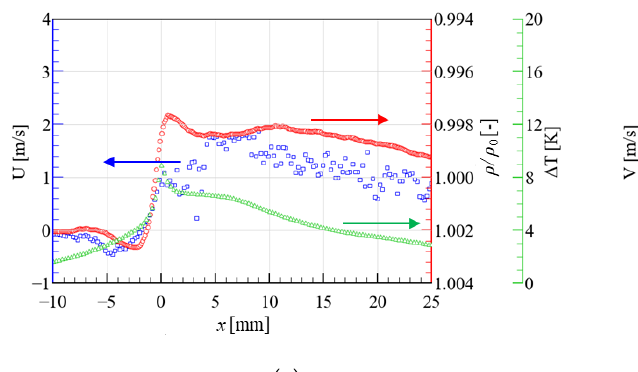
Figure 17. x -profiles of the flow, density field of the wire-PA: ( a ) x -profiles of the horizontal velocity ( y = 0.8 and 2.171 mm) and density ( y = 0.772 and 2.161 mm); ( b ) x -profiles of the vertical velocity ( y = 0.8 and 2.171 mm) and density ( y = 0.772 and 2.161 mm). Using the above results, we discuss the forming mechanism of the flow field, density field, and temperature distribution of the wire-PA, according to Figure 18. It is considered that the EHD force radiated from the wire electrode, owing to the diffusive plasma gen- eration around the wire electrode. In other words, not only a forward but also an upward EHD force was generated near the wire electrode. In addition, a Joule heating field was generated around the electrode. As a result, backward flow and a flow jump were induced near the exposed electrode. The absolute values of the horizontal velocity upstream and downstream were at a maximum, where the EHD force balanced with the viscous re- sistance of the wall boundary. The density peak downstream ( x = 1 mm) was explained as follows. It is noted that the density peak is closer to the exposed electrode for the wire-PA than for the plate-PA. Near the wire-exposed electrode, there was expansion, due to Joule heating, but not compression, due to the flow impingement on the wall. Therefore, the air flowing into the plasma region immediately expanded. This explains why the density peak was closer to the wire-exposed electrode. It is considered that the compression of the flow at 1 mm < x < 8 mm caused the inflection of the density profile (see Figure 16b). Meanwhile, at x < 0 mm, the air was compressed, rather than heated. As a result, a region